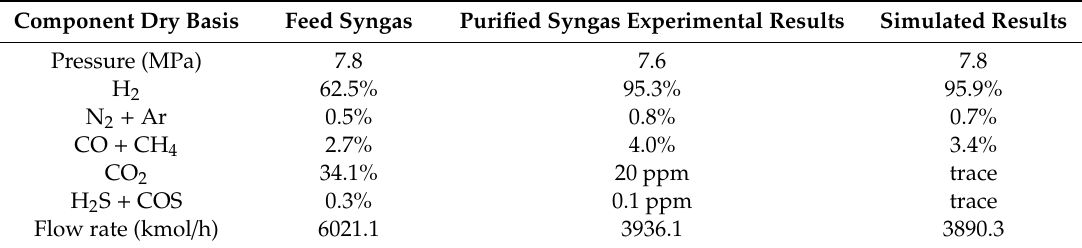
Table 6. Comparison between simulated and experimental results of